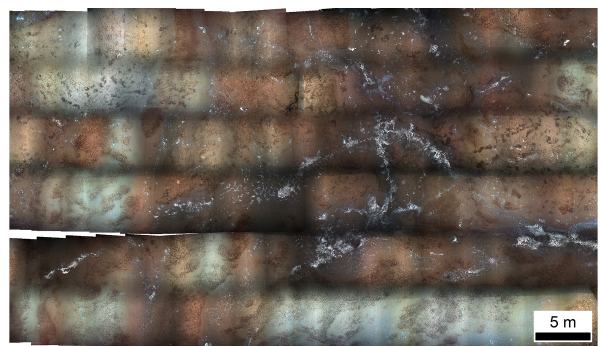
Fig. 13. Excerpt of the photo-mosaic of H˚akon-Mosby Mud Vol- cano; the continuity of the Beggiatoa mats (white patches) and pogonophoran (brown patches) distribution across the mosaic in- dicates that images were accurately registered. The images were obtained from an altitude of about